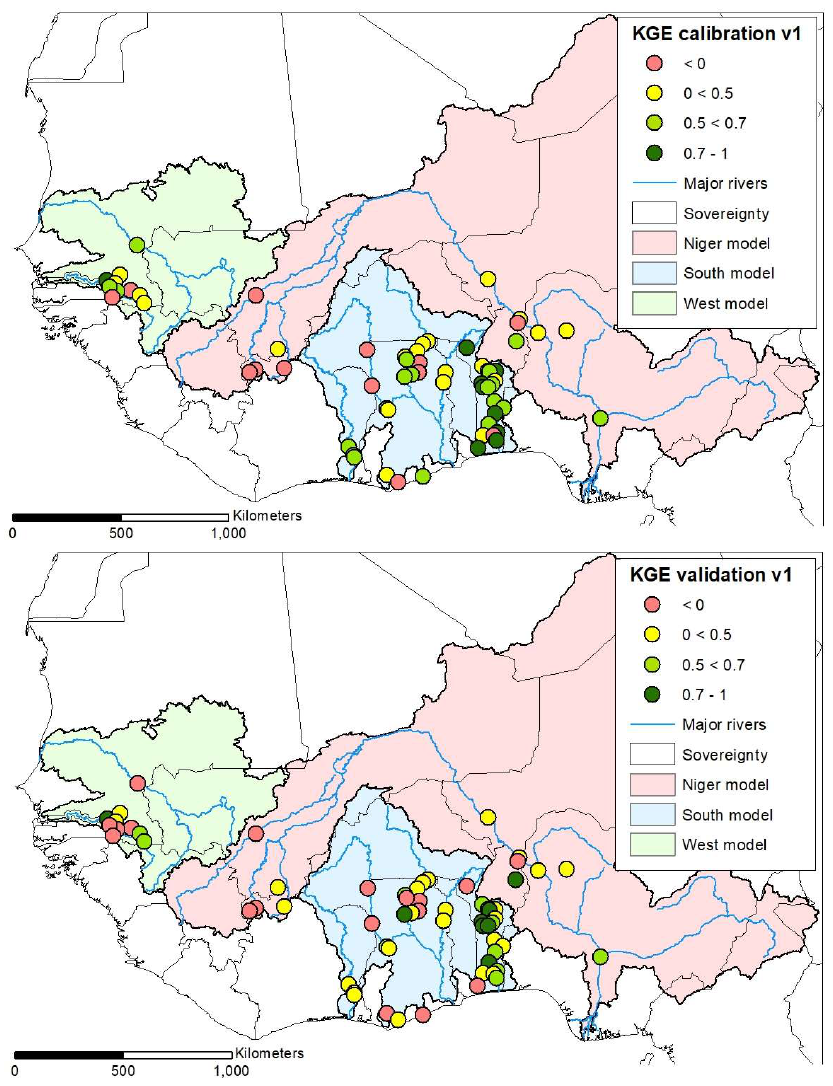
Figure 3. Calibration and Validation Results of the v1 (Global Calibration) Models.